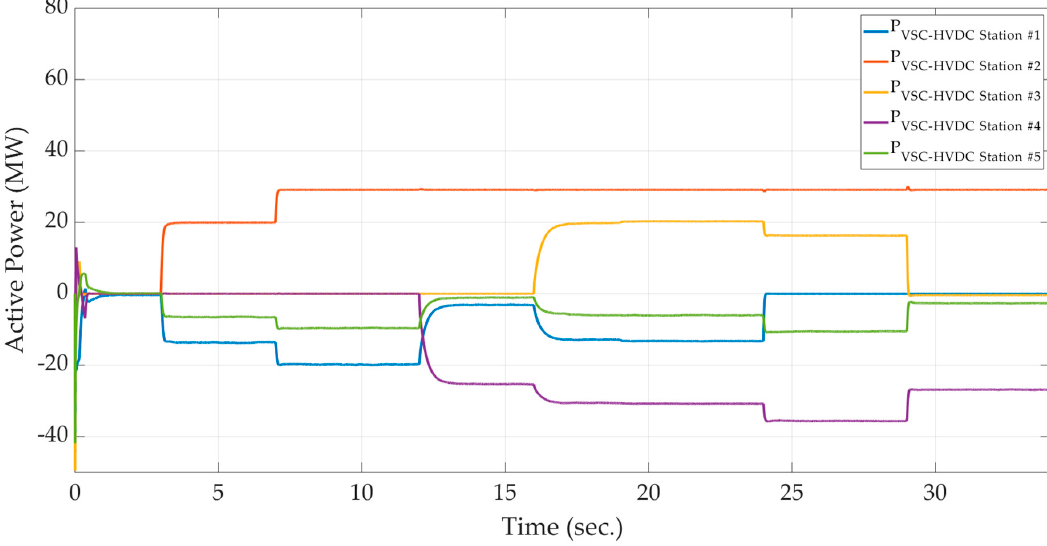
Figure 15. The active power profile of di ff erent VSC-HVDC stations in the second scenario.